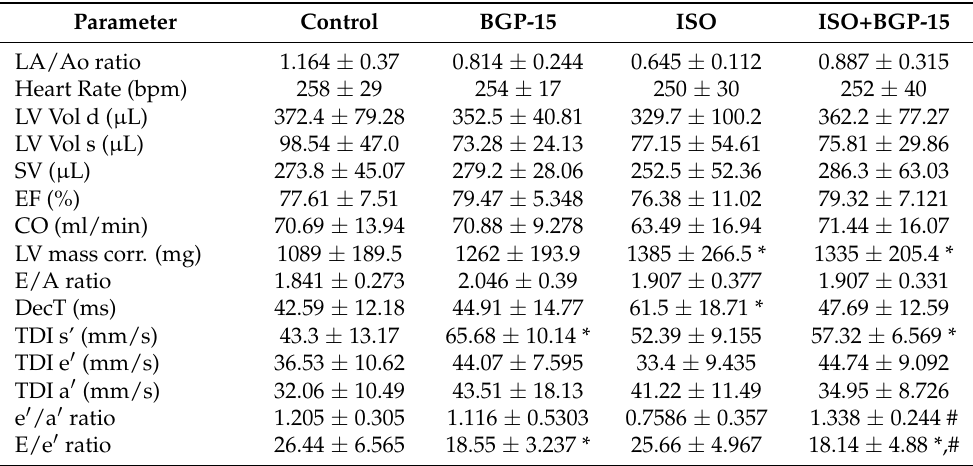
LA: left atrium; Ao: aorta; bpm: beats per minute; LV: left ventricle; Vol: volume; d: diastolic; s: systolic; SV: stroke volume; EF: ejection fraction; CO: cardiac output; E/A: ratio of transmitral early and atrial peak inflow;